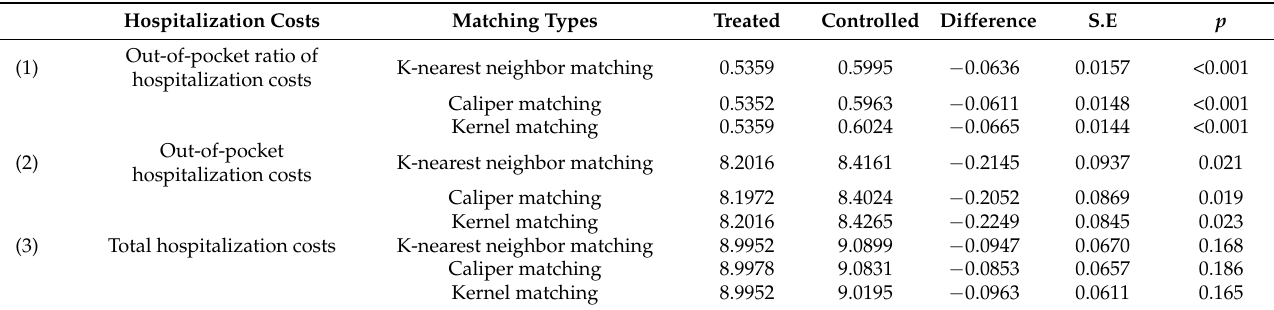
Table 4. PSM results for the impact of instant and manual reimbursement on the hospitalization